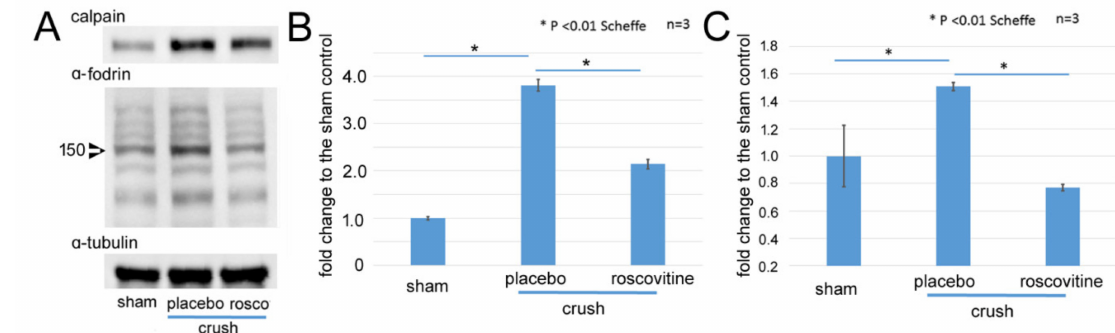
Figure 2. Western blots for calpain-1 and cleaved α -fodrin in the retina after ONC. ( A ): Representative protein bands of calpain-1 and its substrate α -fodrin in extracts from the retina on day 3 after ONC. α -tubulin was used as internal control. ( B , C ): Levels of Calpain-1 ( B ) and cleaved α -fodrin in 150-kDa bands ( C ) are shown as fold changes (means ± SD) to the sham control. Both levels significantly increased in the retina after ONC (placebo), while roscovitine reduced the degree of increase. (* p < 0.01, Scheffe; n = 3 for each